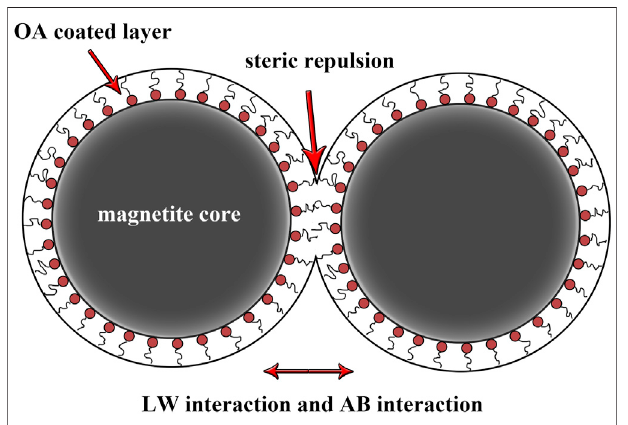
FIGURE 7 | Lifshitz-van der Waals (LW) interaction, acid-base (AB) interaction, and steric repulsion between OA-coated magnetite particles.